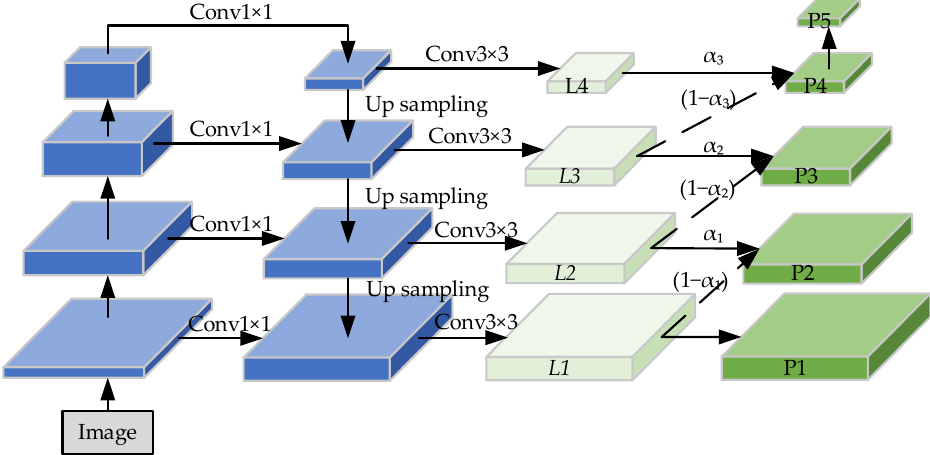
Figure 4. The AFF architecture. α1, α2, and α3 are the adaptive weights that can be learned for each layer. each